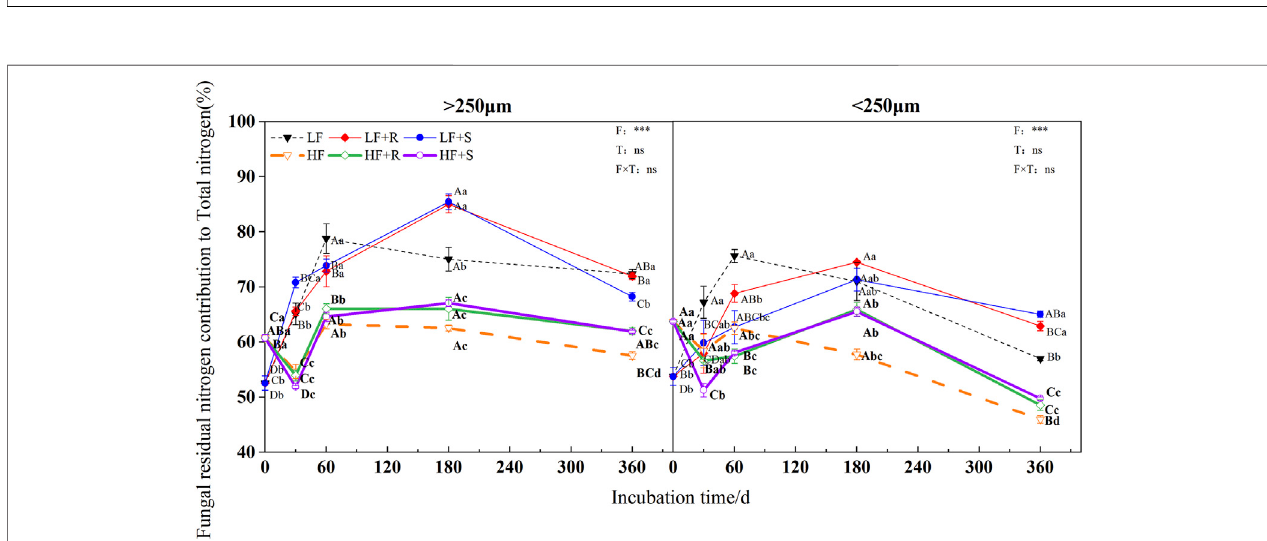
FIGURE6| Fungalresidualnitrogencontribution tototalnitrogen insoilaggregateswithdifferentfertilitylevelsafter theadditionofdifferentpartsofmaizeresidues. Note:LFmeanslowfertility,LF+Rmeanslowfertility+roots,andLF+Smeanslowfertility+Shoots;HFmeanshighfertility,HF+Rmeanshighfertility+roots,andHF+ S means high fertility + Shoots. Uppercase letters represent differences between different periods in the same treatment, and lowercase letters represent differences betweendifferenttreatments atthesameperiod.FortheANOVA,Fmeansfertilitylevel,Tmeansthetypeofmaizeresidues, andF×Tmeansfertilitylevel×typeof maize residues. *,**, and *** mean p < 0.05, 0.01, and 0.001, respectively. ns means no signi fi